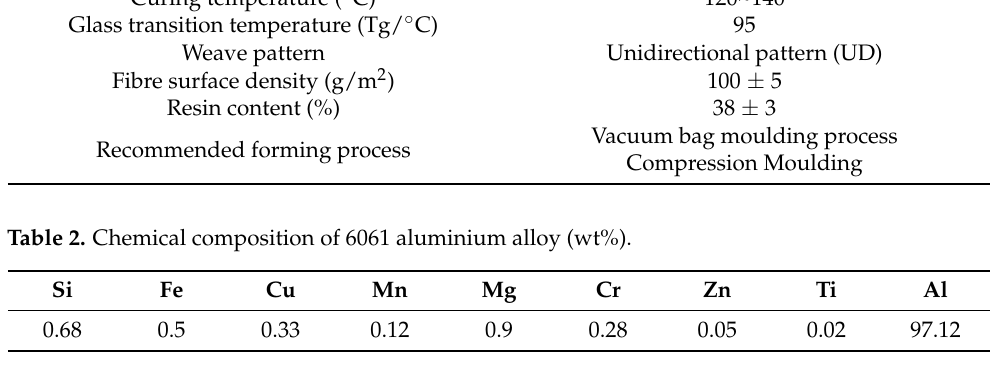
Table 3. Several parameters of the adhesive